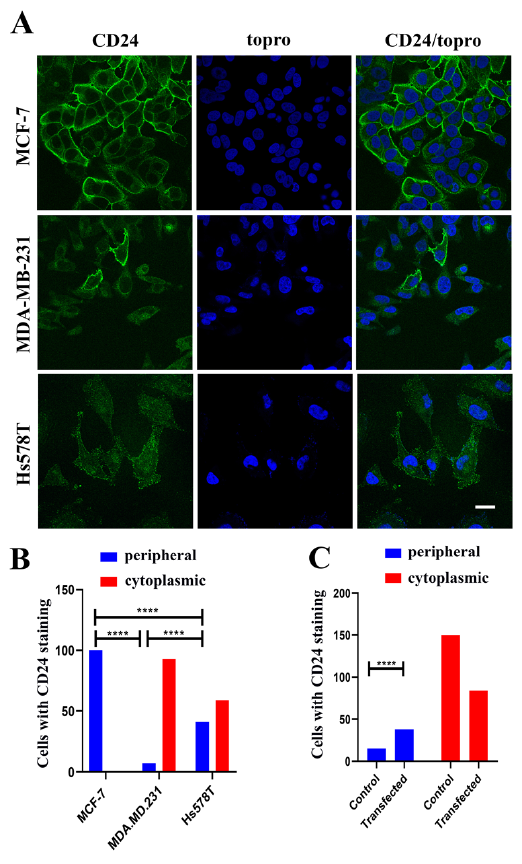
Figure 1. Localization of endogenous CD24 in breast cancer cell lines. ( A ) Representative cell staining for CD24, following immunofluorescence using the SN3 antibody. Scale bar, 20 µ m. ( B ) Evaluation of peripheral staining of CD24 for each cell line. ( C ) Evaluation of peripheral staining of CD24 using SN3 antibody in MDA-MB-231 cells transfected or not with ER-tag CD24. Statistical significance (****) for p < 0.0001 with t -test.